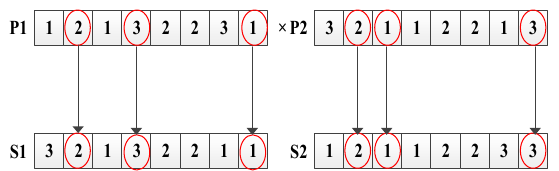
Figure 5. Crossover Operator Based on the Process Coding.